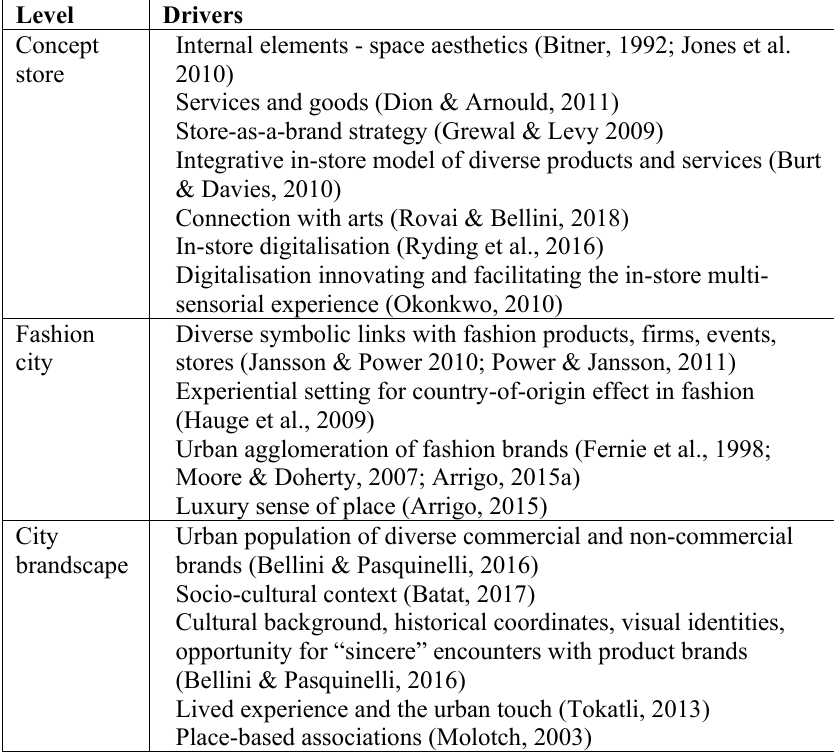
Table 1: Drivers of the Luxury Store Experience from the Literature Review